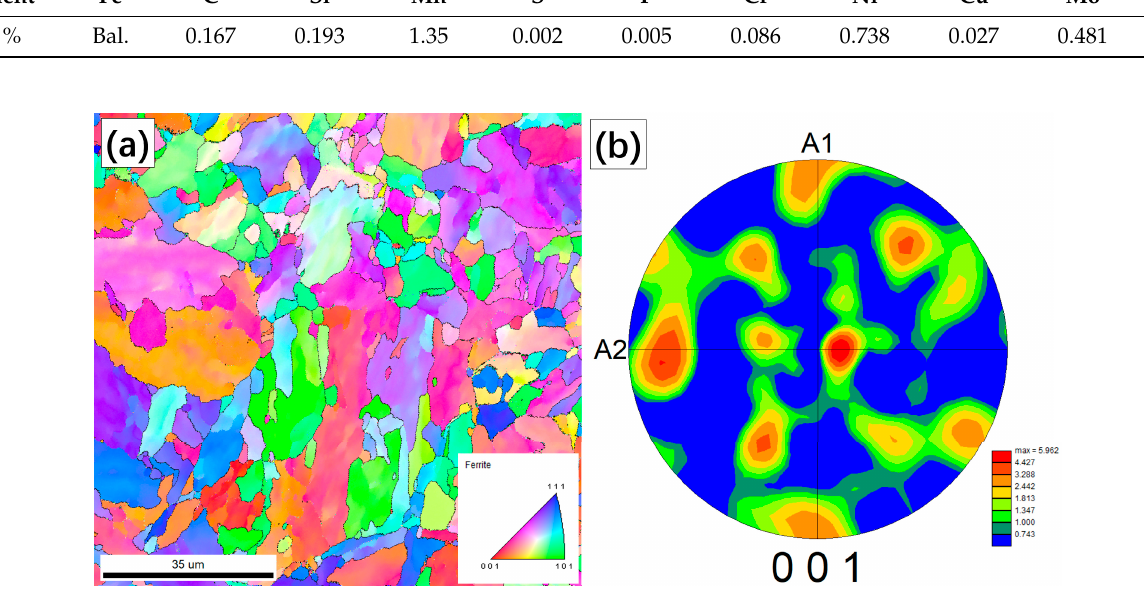
Figure 1. EBSD results including ( a ) grain orientation distribution map and ( b ) pole figure (PF) of the original RPV steel, showing equiaxed grains with random texture.